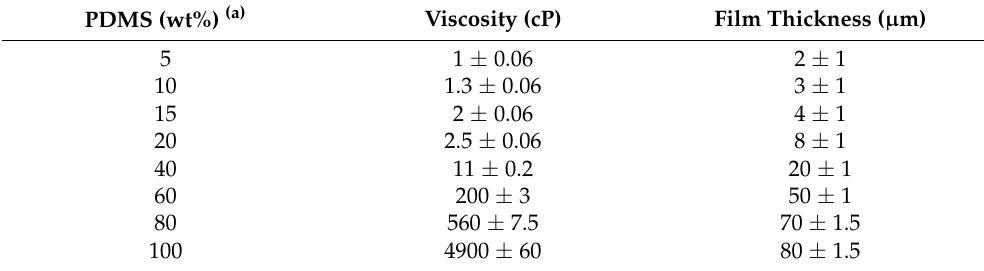
Table 1. Thickness of films obtained from polymeric solutions with different PDMS contents.